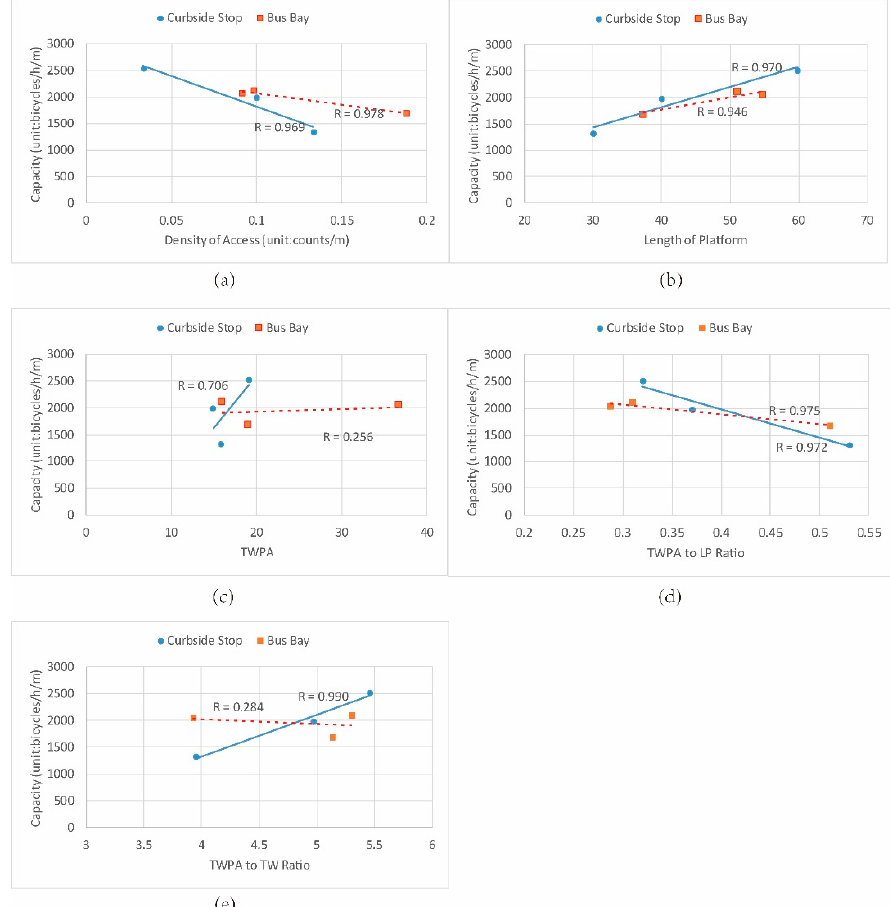
Figure 8. ( a ) Relationships between Capacity of Bypass and Density of Access; ( b ) Relationships between Capacity of Bypass and Length of Bus Platform; ( c ) Relationships between Capacity of Bypass and TWPA; ( d ) Relationships between Capacity of Bypass and TWPA-to-LP Ratio; ( e ) Relationship between Capacity of Bypass and TWPA-to-TW Ratio.